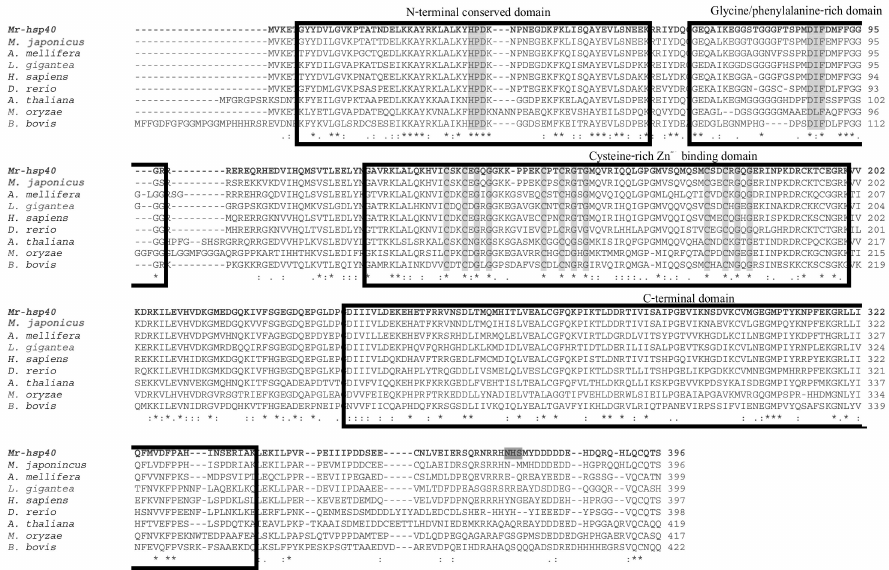
Figure 3. Multiple sequence alignments of Mr-hsp40 with those of other species found in the GenBank database. HSP40 family signature sequences and the consensus sequence “CQTS” at the C-terminus are shown in the open boxes. The symbols (*, : and .) in the CLUSTAL W alignment represent identical residues, conserved substitutions and semi-conserved substitutions, respectively. The accession numbers of the other species are shown in Figure 5.